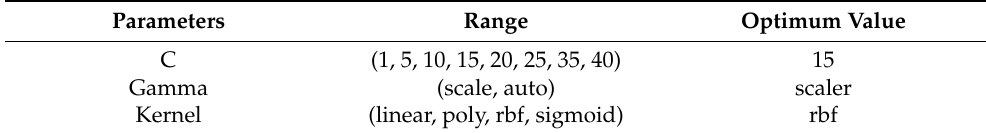
Table 4. SVR grid search parameters.